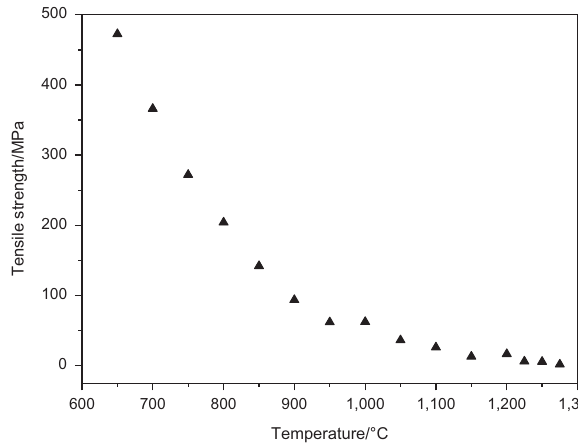
Figure 3: Variation of tensile strength with temperature for TWIP steel.